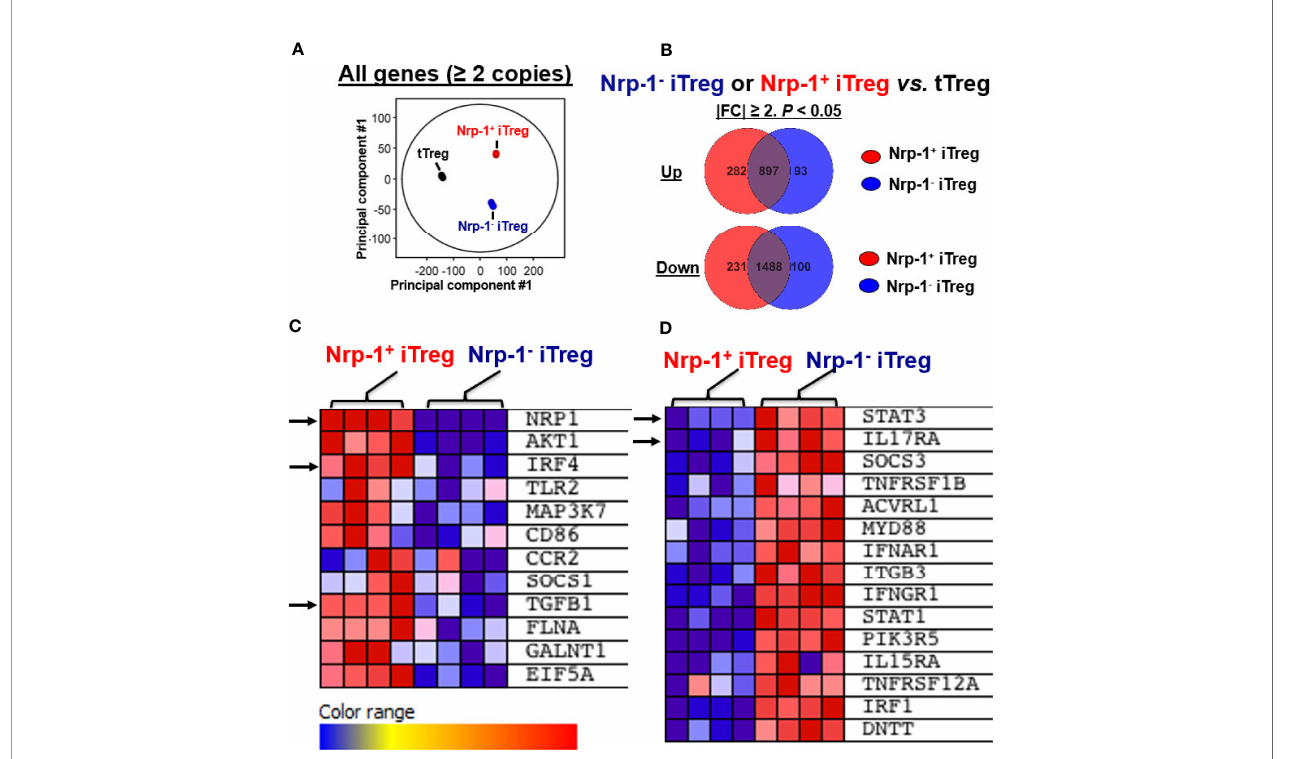
FIGURE 4 | Nrp1 + iTreg and Nrp1 - iTreg are distinct by RNA sequence analysis. (A) Principal component analysis revealed that nTreg (3 replicates), Nrp1 + iTreg (4 replicates), and Nrp1 - iTreg (4 replicates) are distinct. (B) Different gene numbers are demonstrated with more than 2 fold changes (FC) in Nrp1 + iTreg or Nrp1 - iTreg vs. nTreg. Nrp1 + iTreg and Nrp1 - iTreg gene numbers are shared or distinct by Mann-Whitney unpaired analysis ( p <0.05). (C, D) some signi fi cantly altered genes (|FC| ≥ 1, p <0.05) in Nrp1 + iTreg vs Nrp1 - iTreg were shown by Gene Set Enrichment Analysis